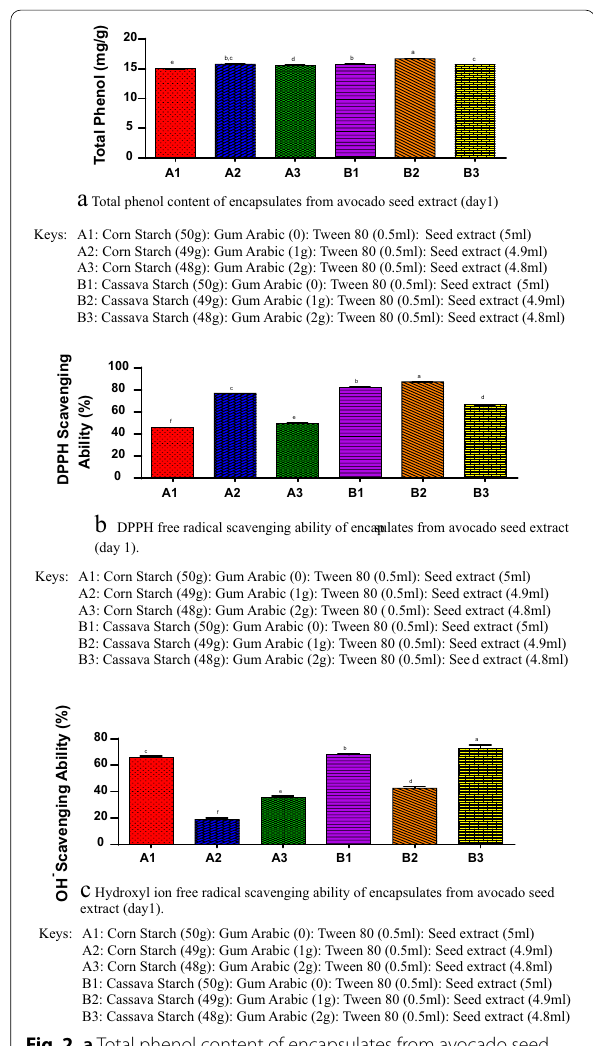
B3: Cassava Starch (48g): Gum Arabic (2g): Tween 80 (0.5ml): Seed extract (4.8ml) Fig. 2 a Total phenol content of encapsulates from avocado seed extract (day1). b DPPH free radical scavenging ability of encapsulates from avocado seed extract (day 1). c Hydroxyl ion free radical scavenging ability of encapsulates from avocado seed extract